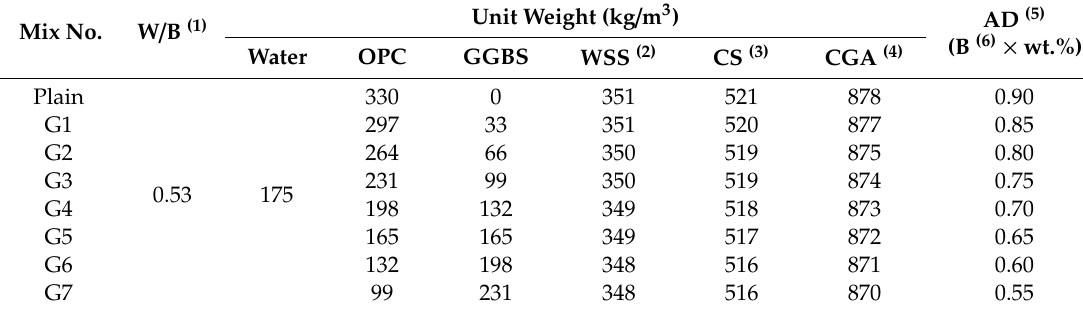
Table 4. Mixing proportions of the